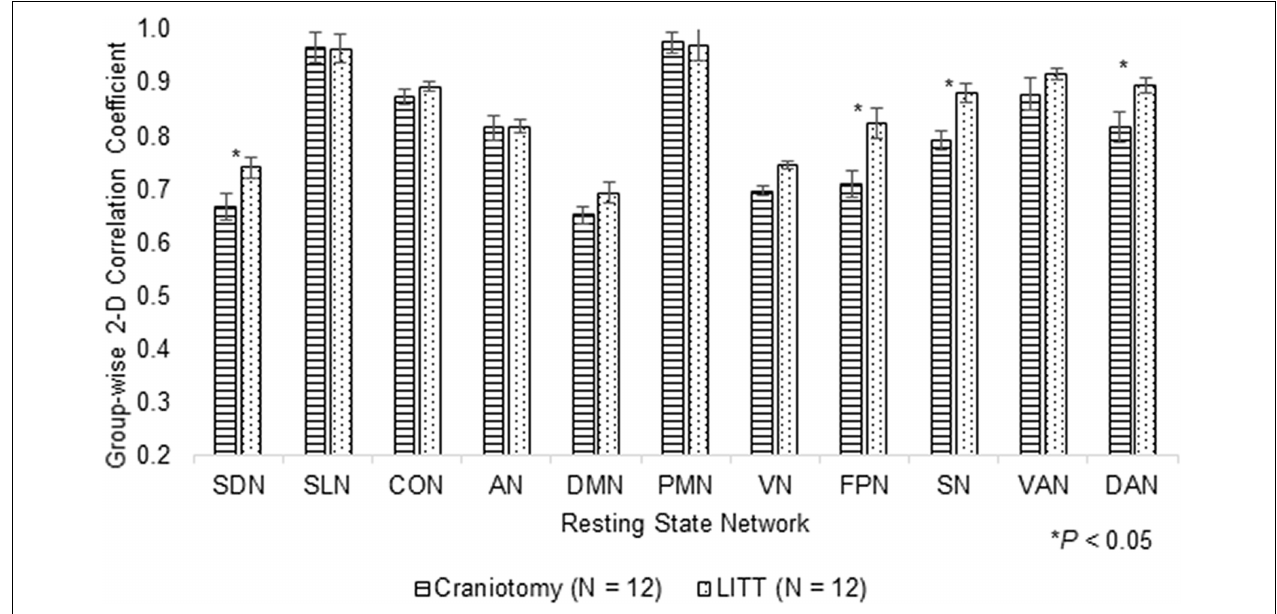
FIGURE 6 | Group-wise 2-dimensional correlation coefficients between pre-operative and post-operative RSNs (resting-state networks) between patients who underwent craniotomy and LITT (laser interstitial thermal therapy). 4 RSNs among LITT patients showed a higher degree of correlation between scans than among craniotomy patients (one-tailed Student’s t -test, assuming unequal